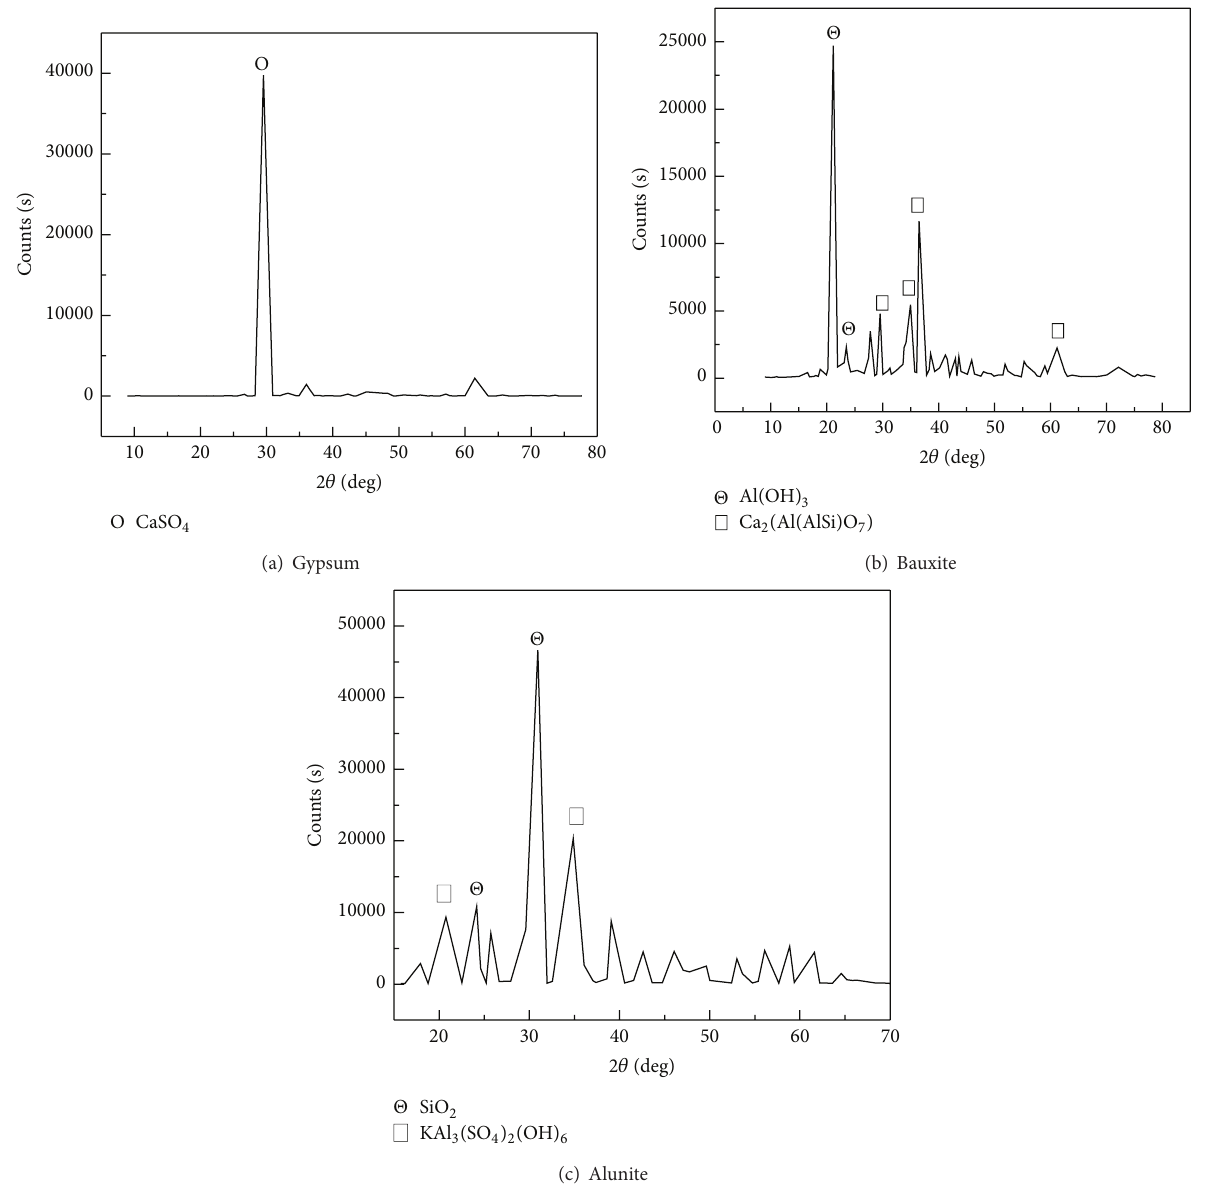
Figure 1: XRD patterns of mineral admixtures. Table 3: Orthogonal factor level